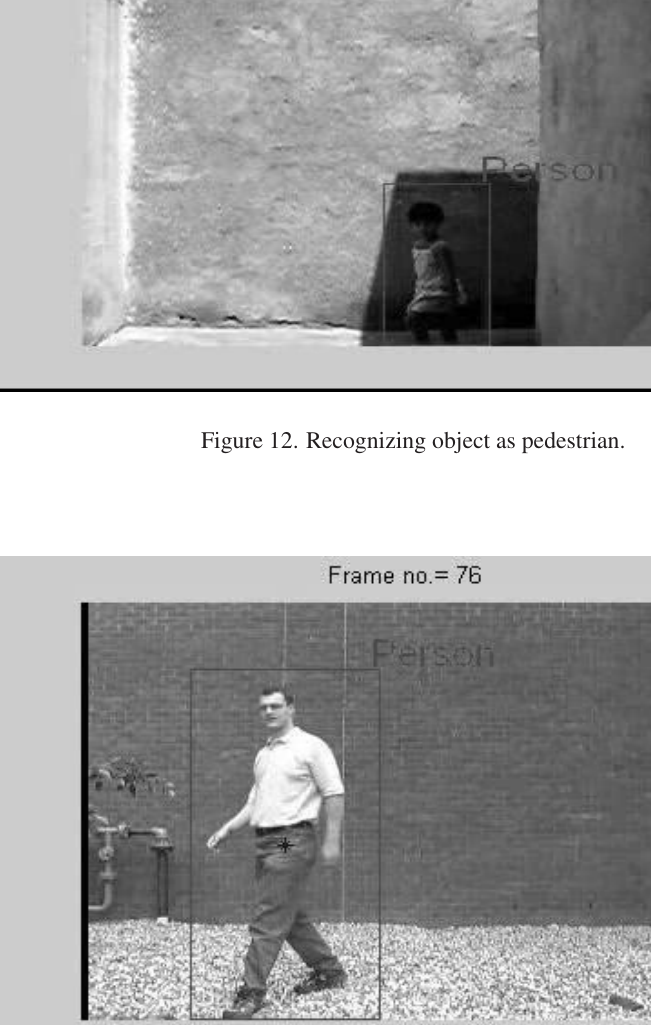
Figure 13. Recognizing object as